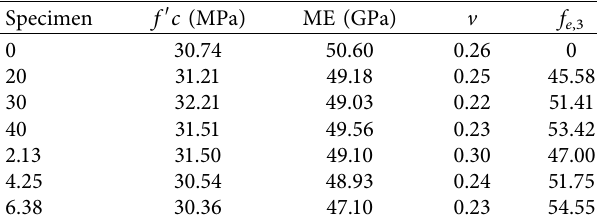
Table 8: Average results of the performed test.